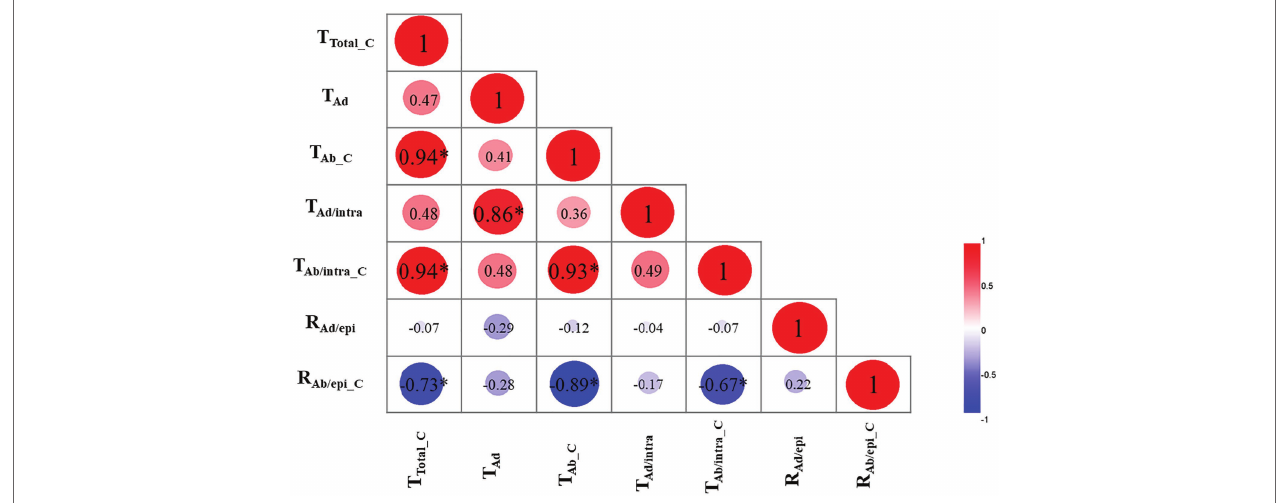
FIGURE 5 | Correlation analysis of cuticular transpiration rate (or resistance; R 2 ). T Total_C : the total cuticular transpiration rate; T Ad : the adaxial cuticular transpiration rate;